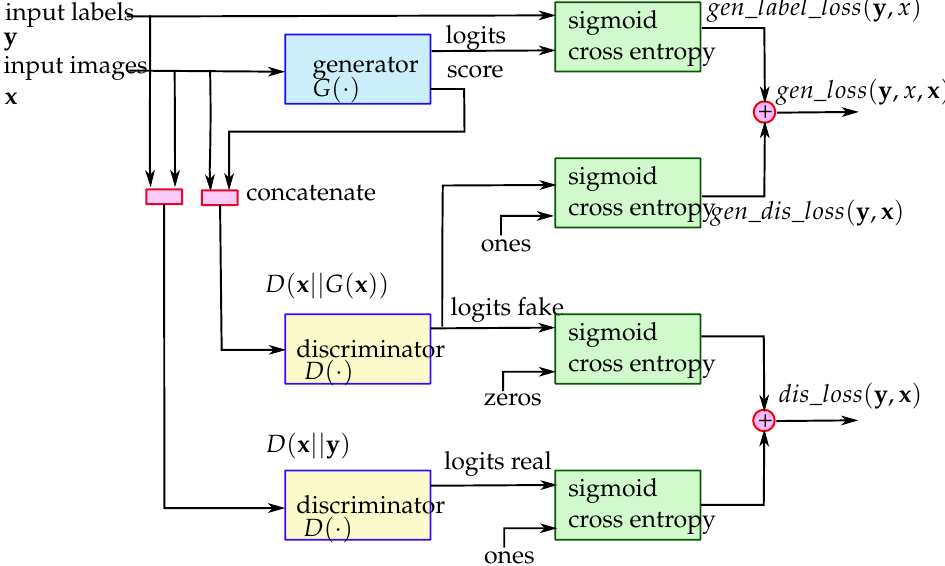
Figure 4. The flow of data and loss functions between the generator and